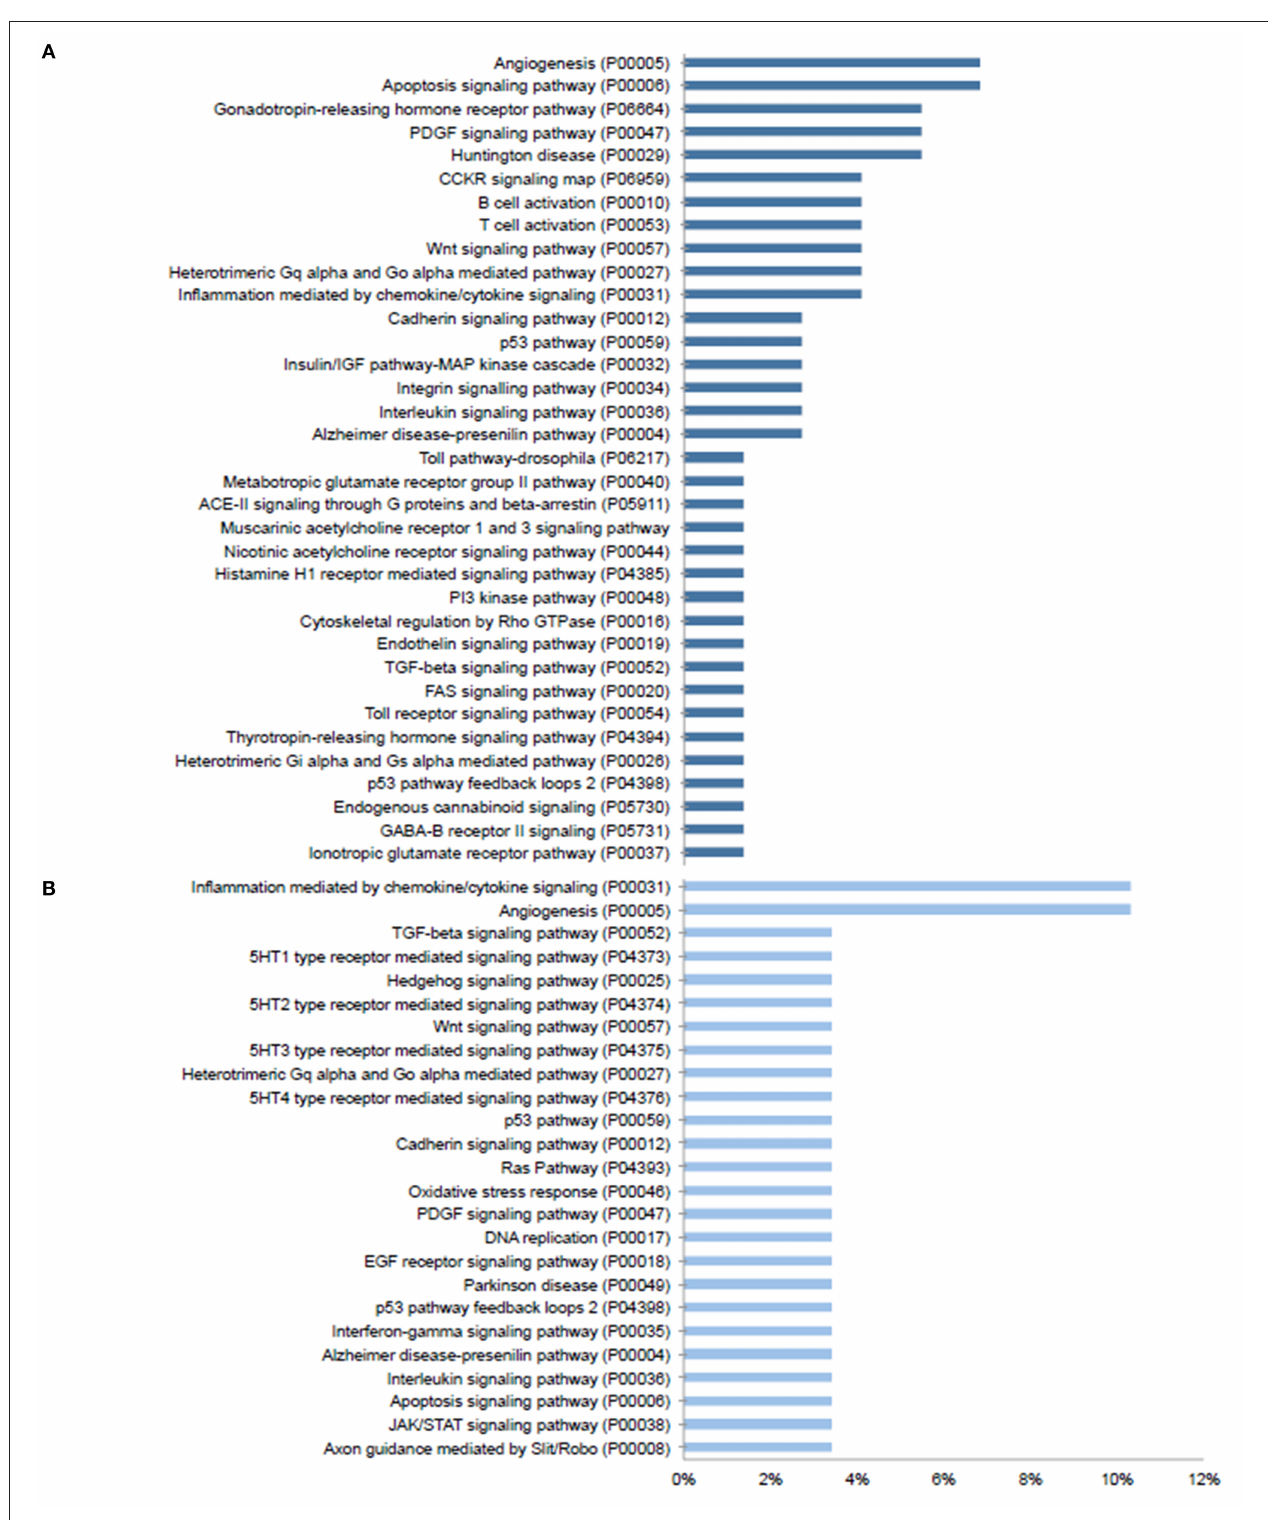
FIGURE 4 | PANTHER pathway analysis of steroid responsive gene expression in the adult mouse spiral ganglion neurons after treatment with transtympanic vs. systemic steroids. Panther pathway classification of 70 upregulated (A) and downregulated (B) differentially expressed genes (DEGs) in adult mouse spiral ganglion neurons (SGN) exposed to transtympanic steroids (TTS) compared to systemic steroids (SS). Bars represent the percentage of DEGs classified to each pathway category.